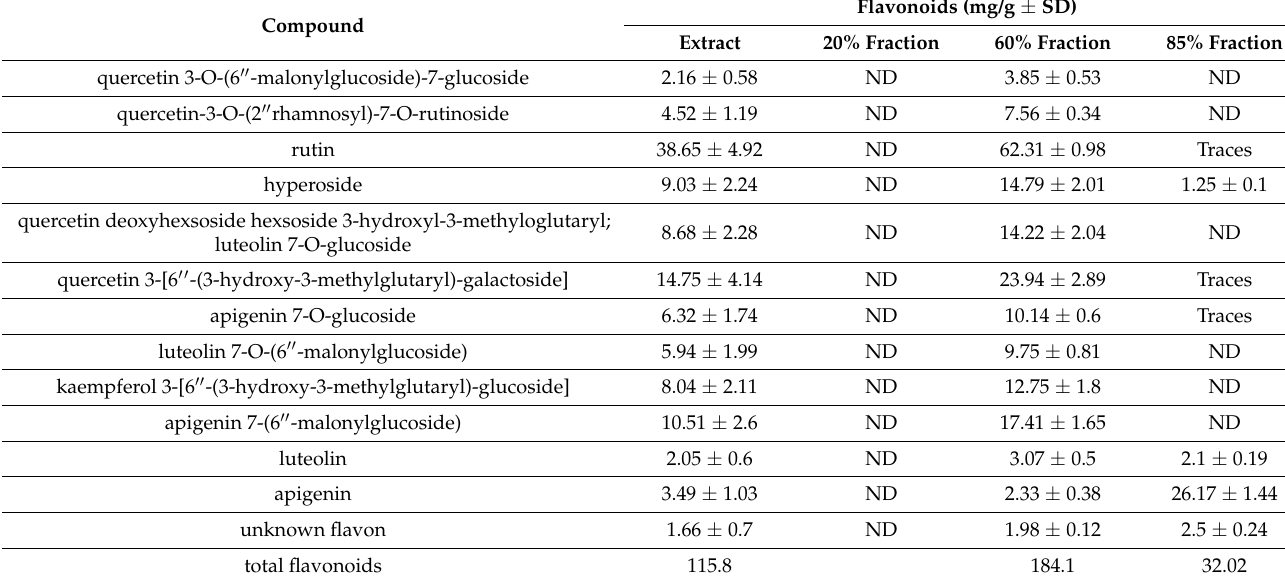
Table 3. Content of flavonoids in the extract from G. hederacea and its fractions.